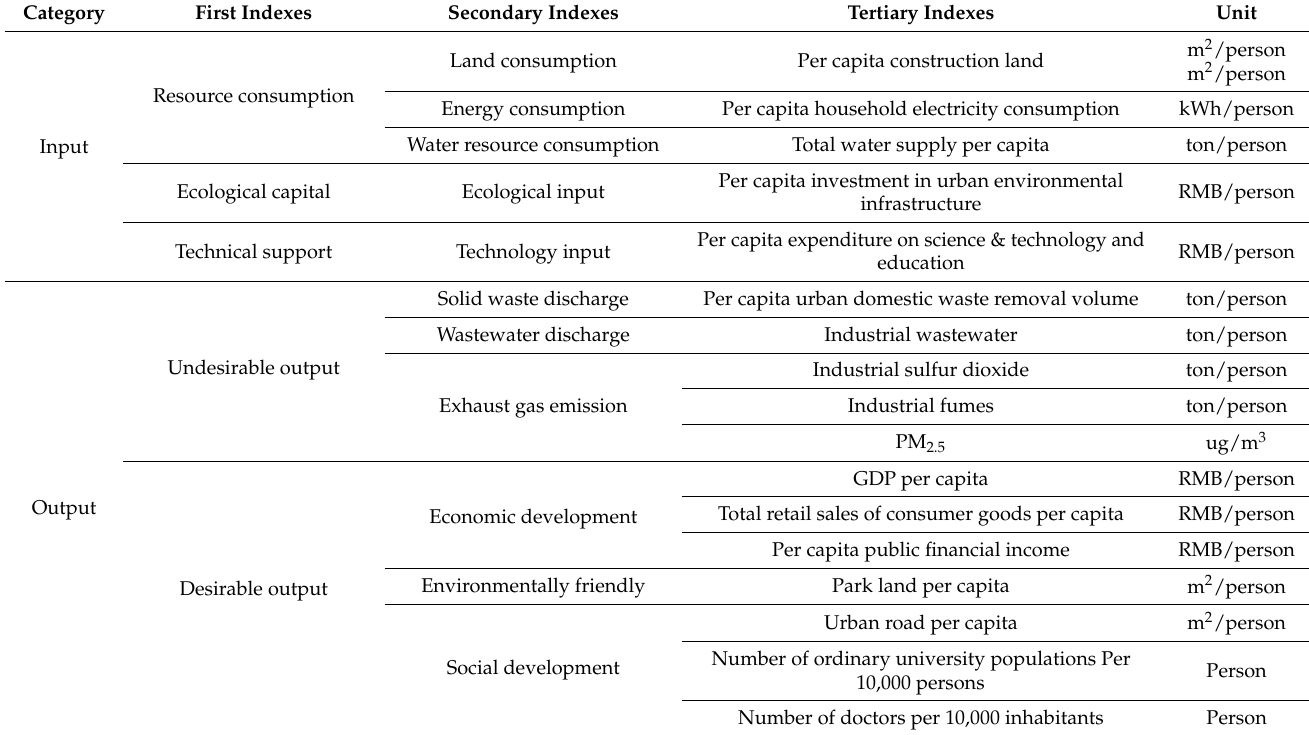
Table 2. Appraising indicator system of the EWP in the YREB.